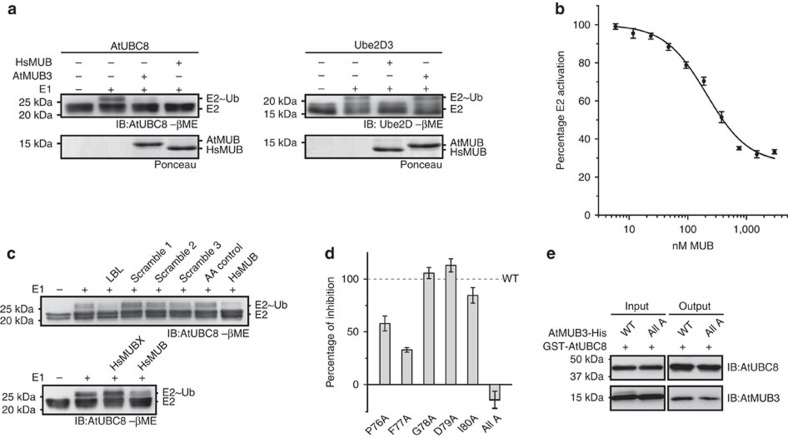
Functionally conserved MUB LBL is sufficient for inhibition of E2∼Ub formation.(a) Thioester-formation assays, as described in Fig. 2, of AtUBC8 (left) and Ube2D3 (right), each exposed to both Arabidopsis and human MUBs. (b) Using HTRF–FRET, Ube2D3 activation was monitored with indicated concentrations of HsMUB to establish an inhibition curve. The initial velocity was linear over the first 10 min and is represented as percent E2 activated, with 100% velocity taken in the absence of MUB and 0% in the absence of ATP. Plot represents three independent assays±s.e.m., fit to the one-site binding equation. An additional three assays fit to the Hill equation with coefficient n produced nearly identical results with n∼1. See also Supplementary Fig. 1. (c) Top panel, thioester-formation assays of AtUBC8 exposed to N-LKLPFGKT-C (HsMUB LBL), three scrambled peptides or an amino acid mixture equimolar to the human LBL (AA control). Bottom panel, thioester-formation assays of UBC8 exposed to HsMUB chimeric for the Ub α2β5-loop (HsMUBX). (d) Quantification of AtMUB3 LBL mutant protein inhibition was performed by normalization to WT as 100% (dashed line),±s.e.m. and n=3 for all data points (Supplementary Figs 6 and 7). AtMUB3 with the LBL core converted to alanines is P76A F77A G78A D79A I80A (All A). (e) An interaction study between AtUBC8 and AtMUB3 All A LBL mutant proteins was carried out using GST pull-down assays. The input and output proteins were visualized by immunoblotting (IB) as indicated. See also Supplementary Figs 14, 15 and 16).